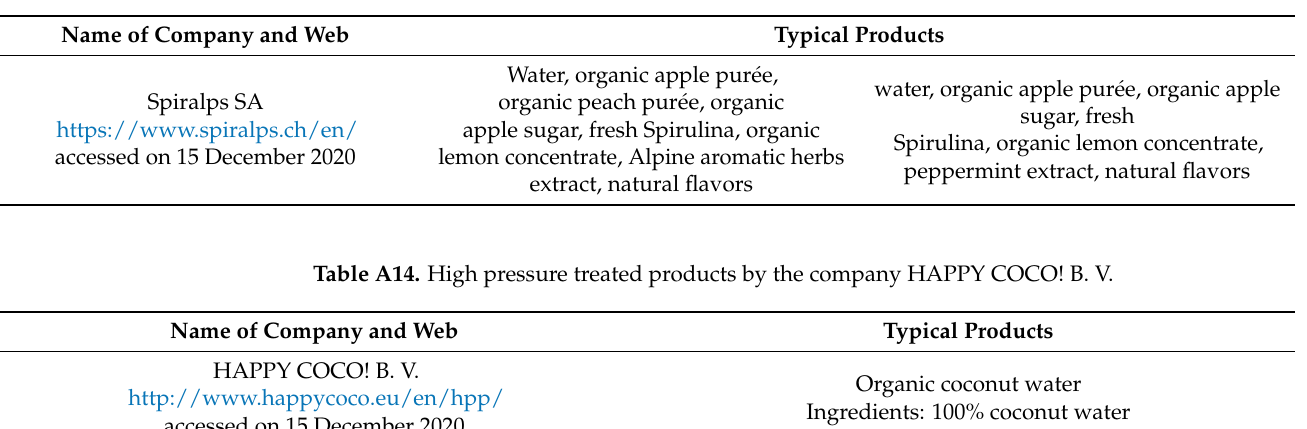
Table A13. High pressure treated products by the company Spiralps SA.